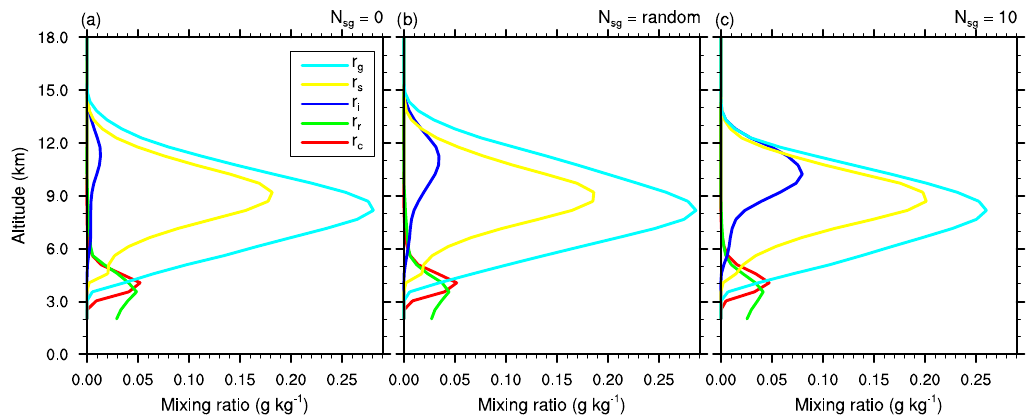
Figure 8. Mean profiles of condensate mixing ratios r c , r r , r i , r s , and r g (in gkg − 1 ) of the STERAO simulations corresponding to (a) the N sg = 0 . 0 case, (b) the “RANDOM” case, and (c) the case with N sg = 10 . 0.